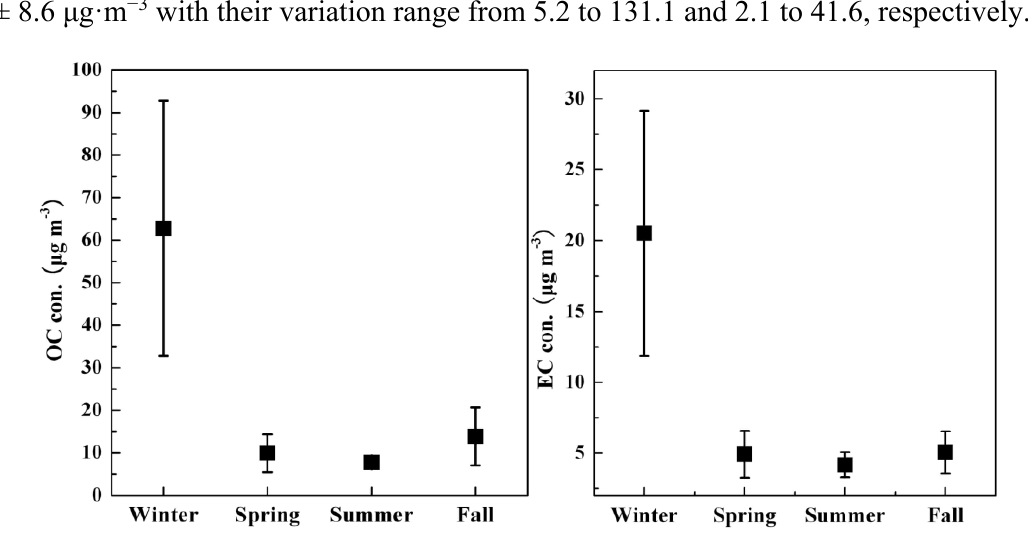
Figure 2. Average concentrations of organic carbon (OC) and elemental carbon (EC) in PM2.5 in